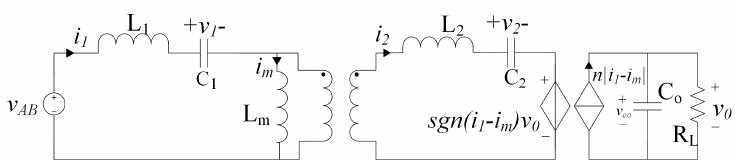
Figure 3. CLLC resonant converter equivalent circuit